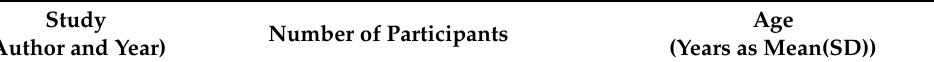
Table 3. Characteristics of research participants in studies of new technologies and hand function in MS patient